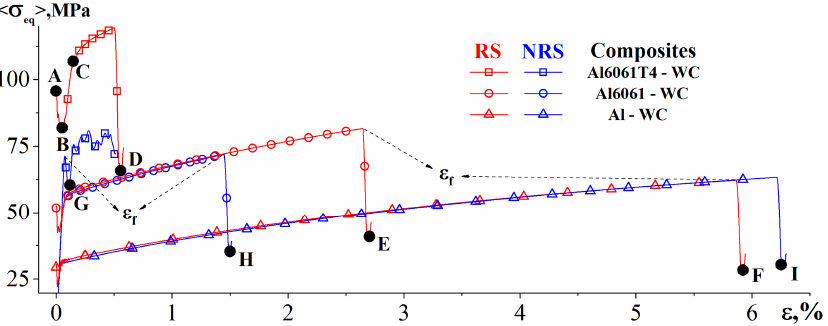
Figure 7. Stress–strain curves under tension (NRS) and tension after cooling of composites with different matrices and with a tungsten carbide particle (RS).